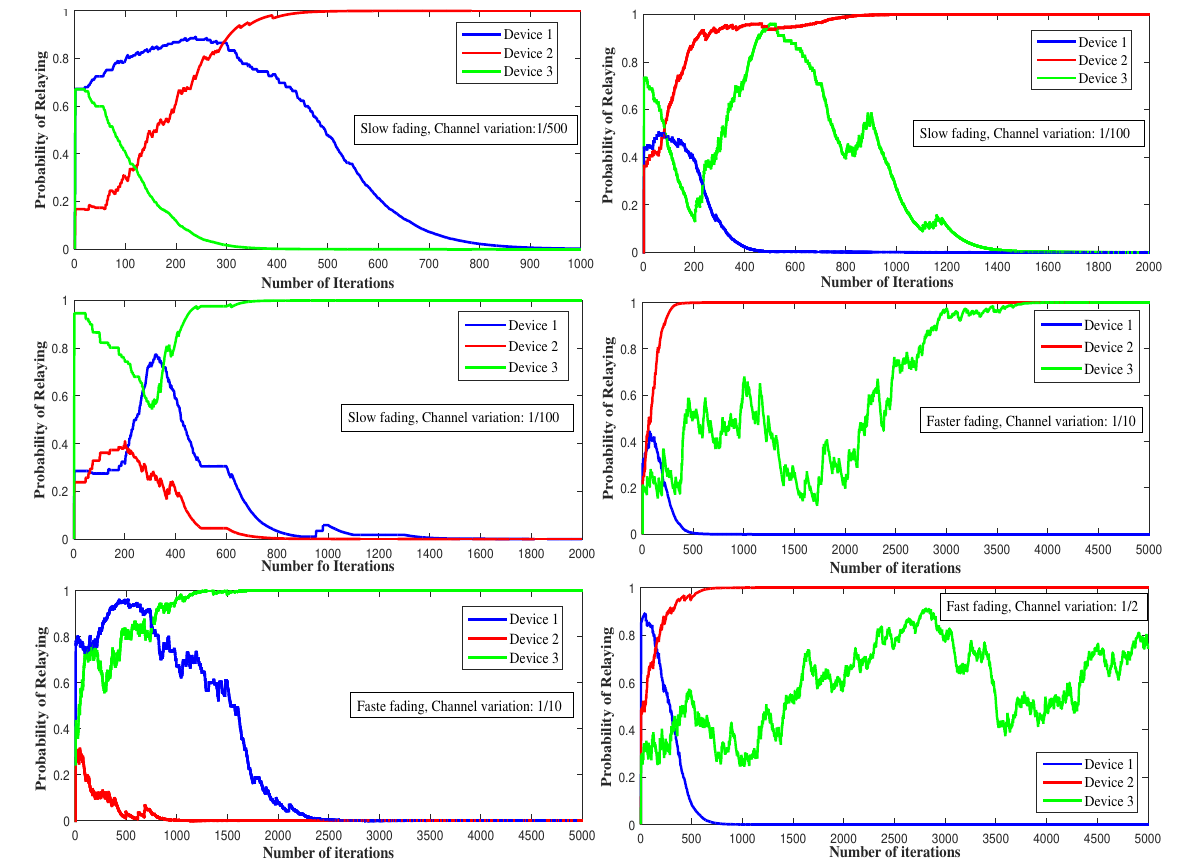
Figure 7. The effect of channel fading on the convergence toward a pure Nash equilibrium using LRI. Figure 8 provides an illustrative example of p ∗ convergence, under Gibbs-Boltzmann i scheme. It discovers the mixed equilibrium strategies in the case of a fast-fading channel. The proposed scheme, contrary to the biform game, considers random channels and estimated utilities. In the figure, device 2 serves as a relay for most of the time (65% of the time), then device 1 with 45% and finally device 3 with 5%. Device 1 is the strongest but it is the most affected by both devices’ interference. By adopting the indifferent mode, it chooses to communicate through cellular for half of the time and D2D for the other half. While device 2, the second strongest device, chooses to communicate through cellular and serve as a relay for most of the time. Device 2 is affected, once in cellular, by device 3 interference only. Thus, to reach high throughput, device 3 needs to stay in D2D mode, this is why device 3 communicates through D2D for more than 90% of the time.